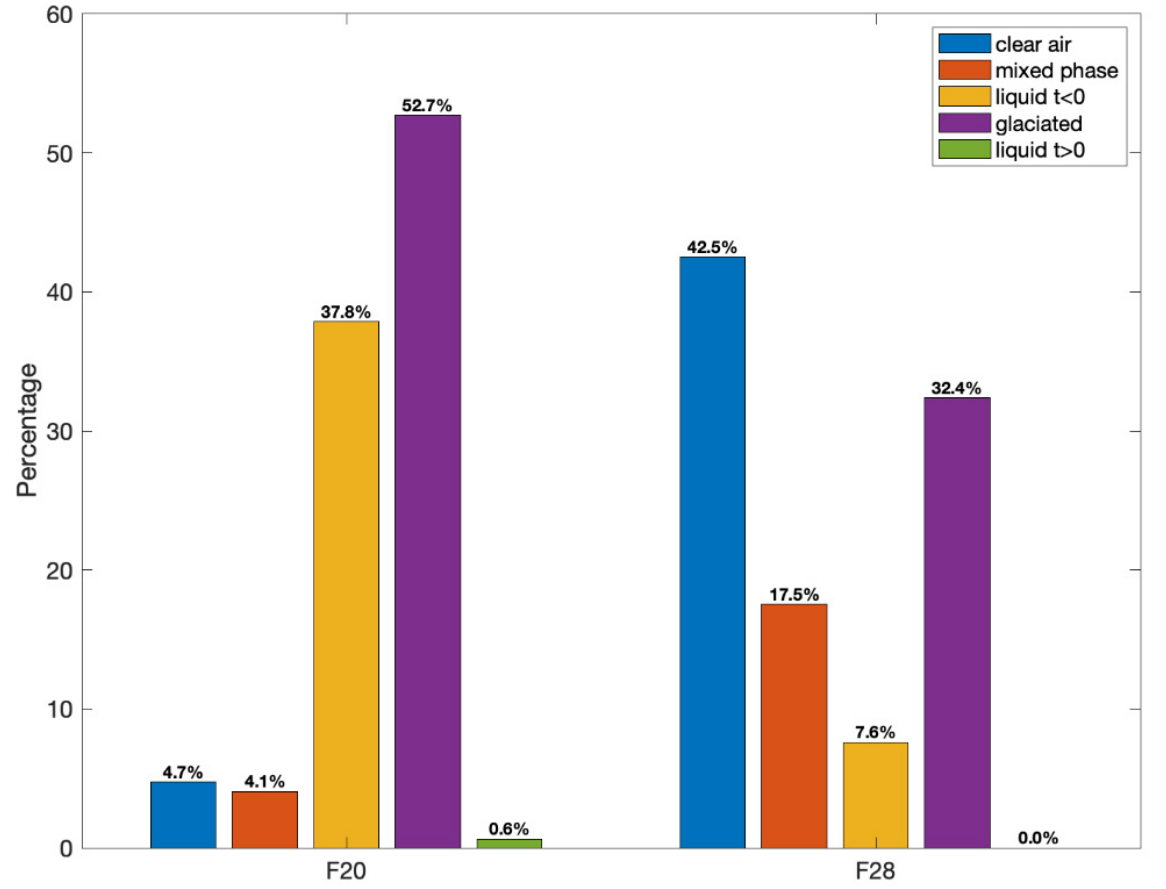
Figure 7. DT classes percentage histogram for flights F20 and F28. Reproduced with permission [20]. Definition of each class is according to the dendrogram in Figure 5.